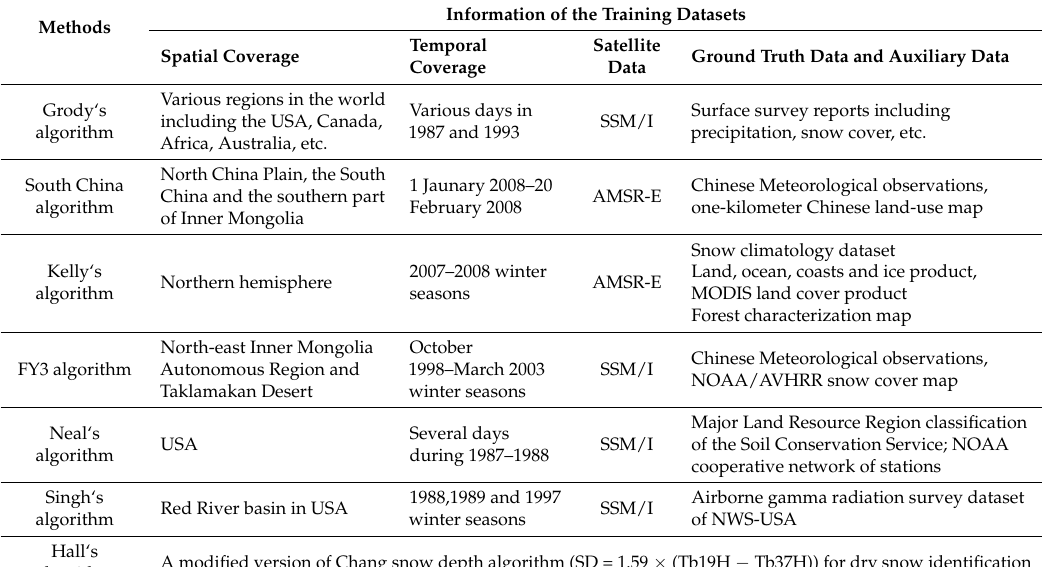
Table 4. Training dataset information for the tested